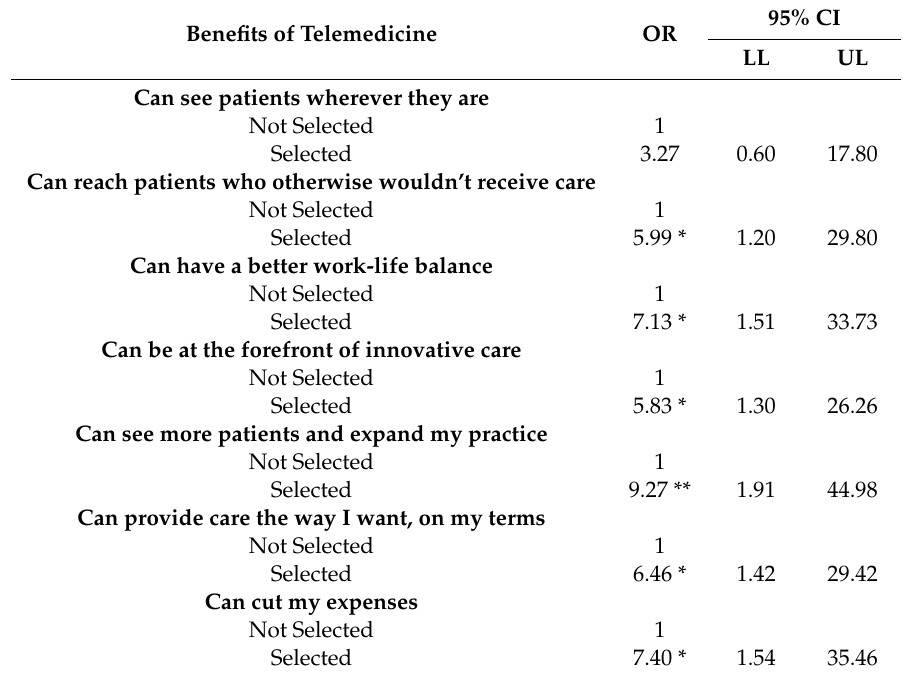
Table 5. Regression for benefits of telemedicine on intentions to use telemedicine in the future. Benefits of